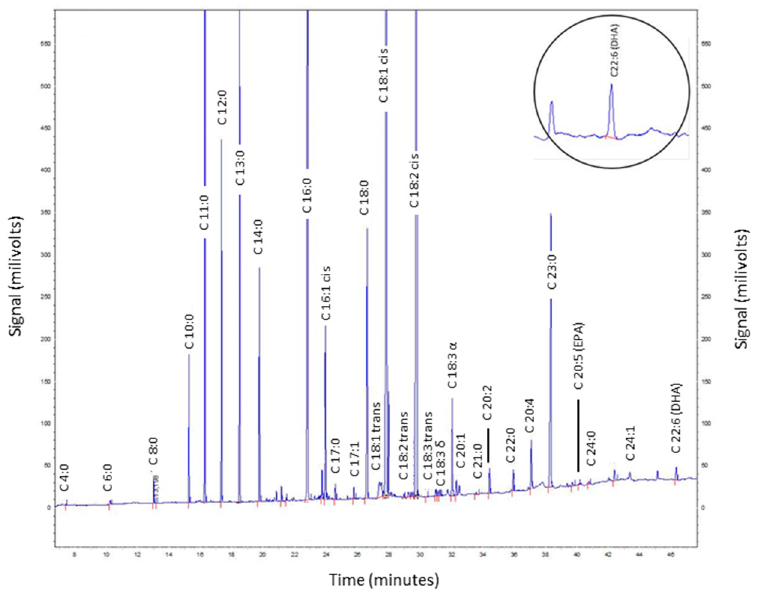
Figure 5. Chromatogram of a human milk sample (ID 5). The DHA elution region is highlighted. Table 3. Docosahexaenoic acid (DHA) values milk from nursing mothers living in the city of Itu, São Paulo.